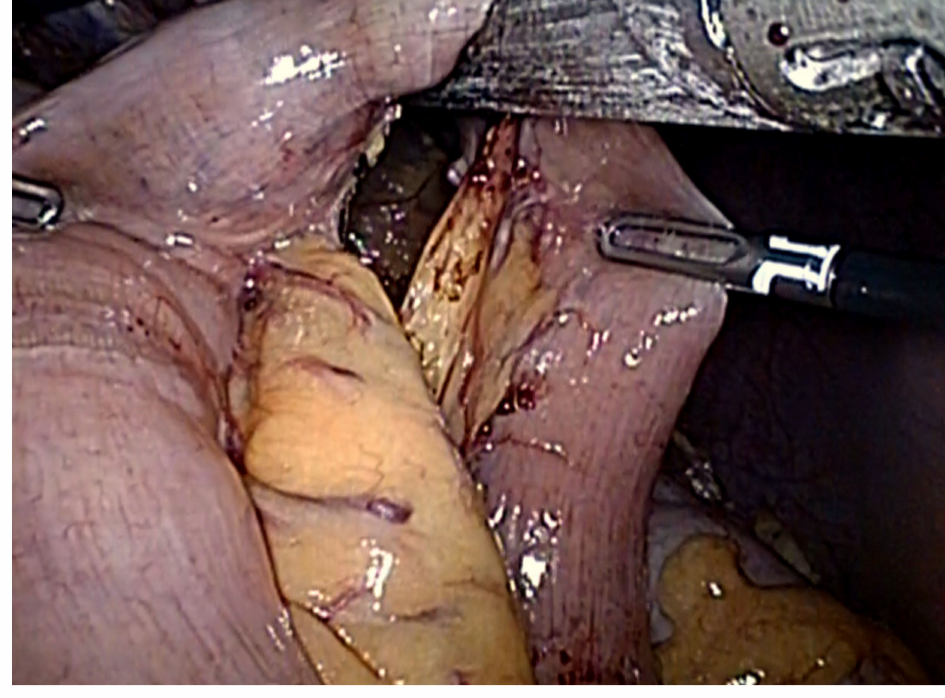
Figure 3. Transection of the jejunum to form the Roux limb of the esophago-jejunal anastomosis.